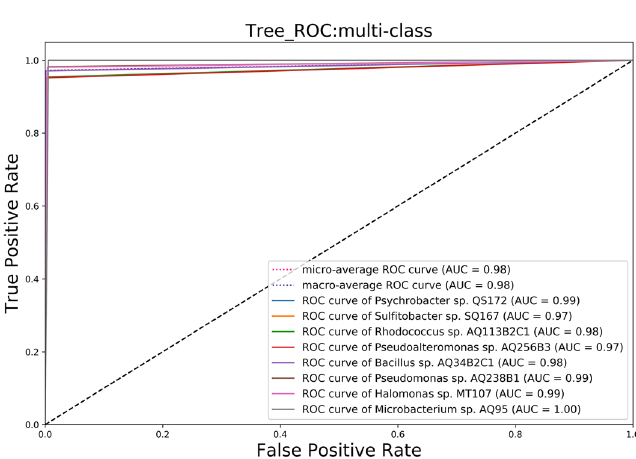
Figure 5. Receiver operating characteristic (ROC) curves of the Transformer